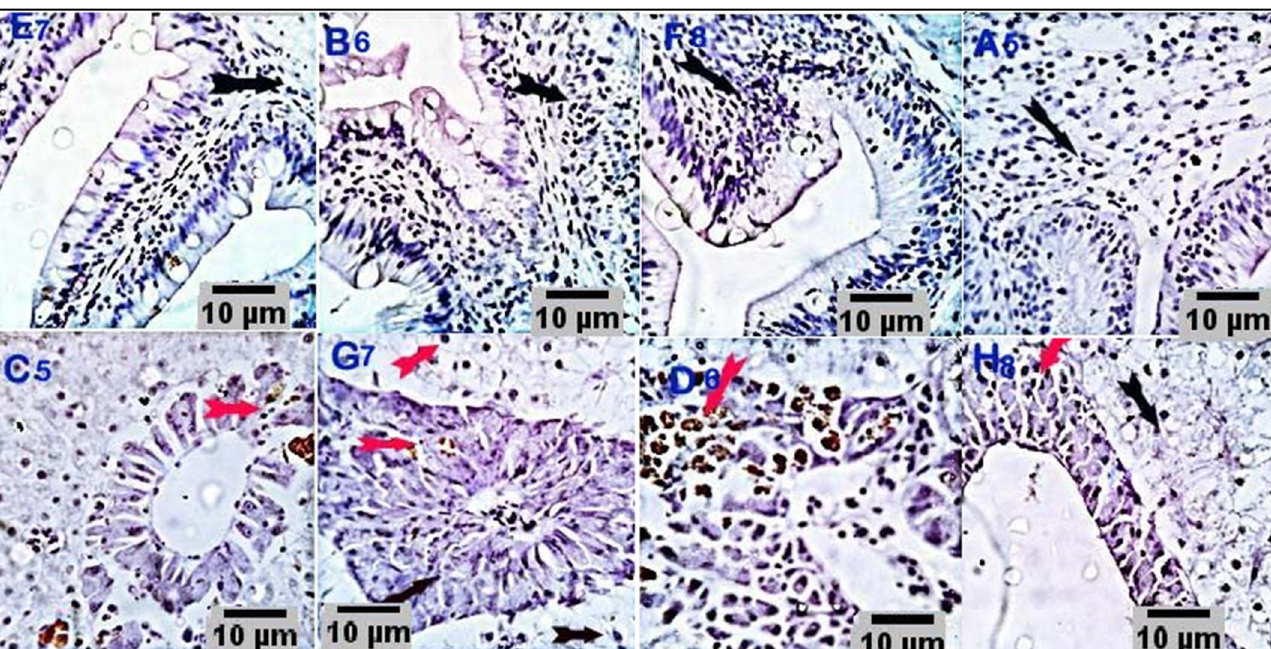
Figure 7. Stained sections of the intestine (E7, B6, F8, and A6) and liver (C5, G7, D6, and H8) of the respective treatment groups (CUR200, CUR400, CUR600, and CUR800, respectively) immunostained against TNF- α . Sections from intestines of different treatment groups (E7, B6, F8, and A6) immunostained against TNF- α , showing a weak positive reaction in a few mucosal and submucosal mononuclear cells (2.5%, 3.5%, 4%, and 14% of cells in CUR200, CUR400, CUR600, and CUR800 groups, respectively). Liver sections (C5, G7, D6, and H8) also demonstrated weak reactivities in a variable number of hepatic and hepatic portal cells (3.9%, 10%, 25%, and 25% of cells in CUR200,